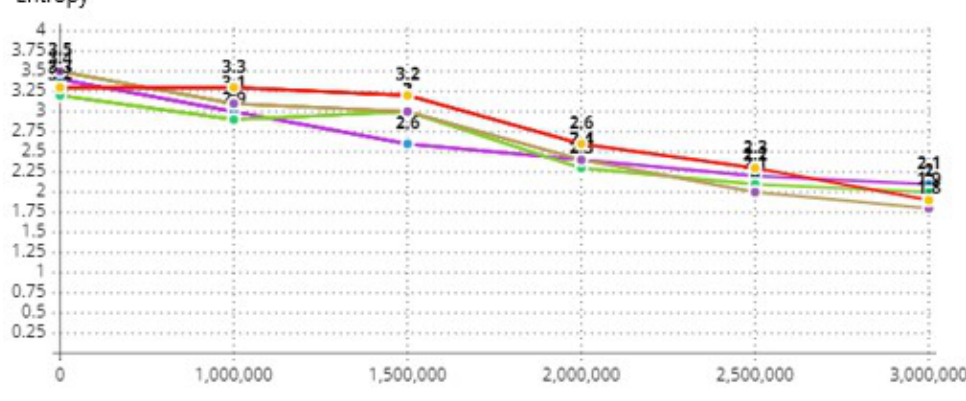
Figure 13. Entropy graph using the SAC algorithm.